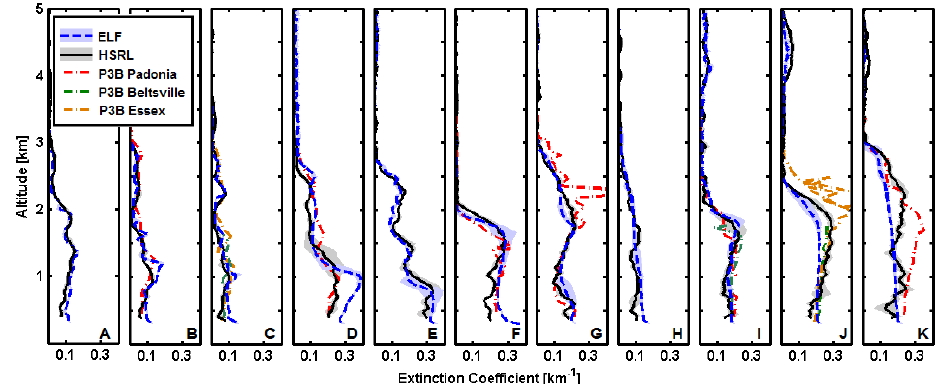
Figure 4. Extinction coefficient profiles obtained by HSRL (black solid lines) and by elastic lidar (blue dashed lines) at 532nm for the cases listed in Table 1. Standard deviations of HSRL profiles are due to the profiles variation during a UMBC overpass ( ∼ 1–2min, ∼ 8 profiles). Standard deviations of ELF profiles are due to profiles variation within 15min centered at the overpass time. The dot-dashed lines represent in situ measurements obtained onboard the P3B over spiral sites that were closest to UMBC (red: Padonia; green: Beltsville; orange: Essex). The in situ profiles have been corrected to the ambient relative humidity.